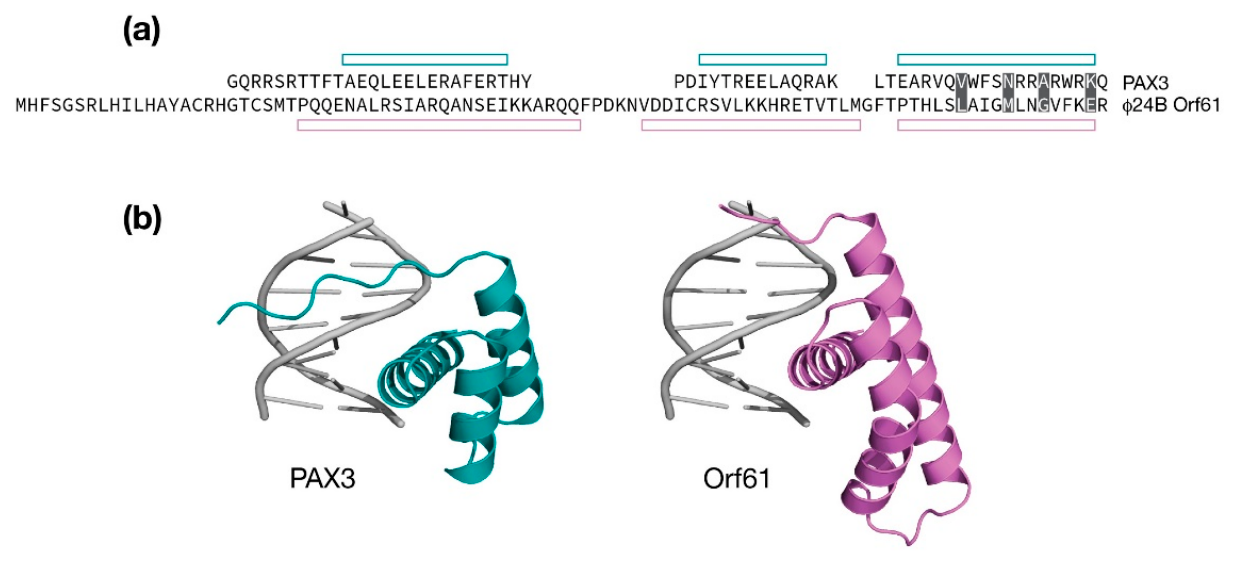
Figure 5. Modeling Φ 24 B Orf61 as a potential DNA binding domain. ( a ) Structure based sequence alignment of Φ 24 B Orf61 and the PAX homeodomain (PDB:3CMY). Open bars indicate the observed or predicted positions of three α -helices. Amino acids that make DNA major groove contacts are shaded. ( b ) Cartoon representation of the PAX3/DNA crystal structure (in teal). An amino-terminal extended segment reaches into the major groove. Cartoon representation of Φ 24 B Orf61 model positioned analogously in the major groove.